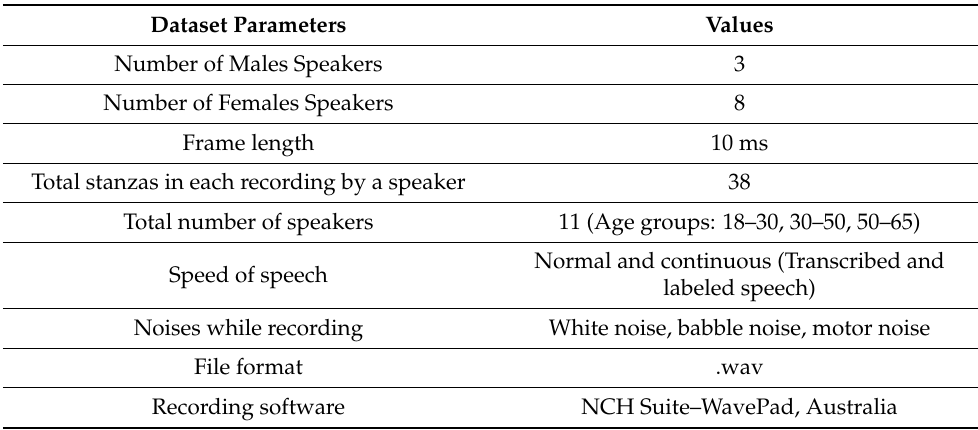
Table 2. Dataset parameters used in the current system.